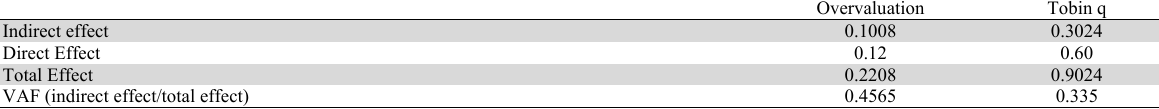
Mediation Testing on the Impact of FCF on MB and Tobin Q through the